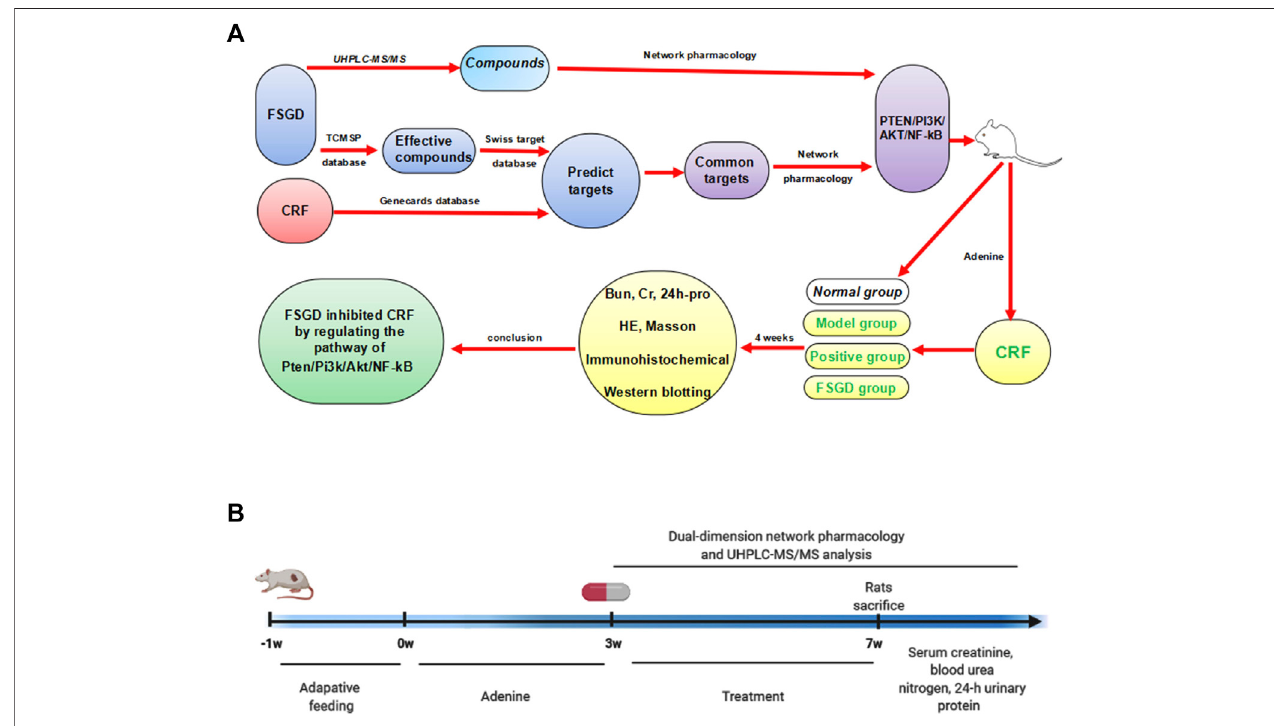
FIGURE 1 | The study schematic illustration of the mechanism for FSGD in CRF. (A) Process of experiments. (B) Timeline of experiments.